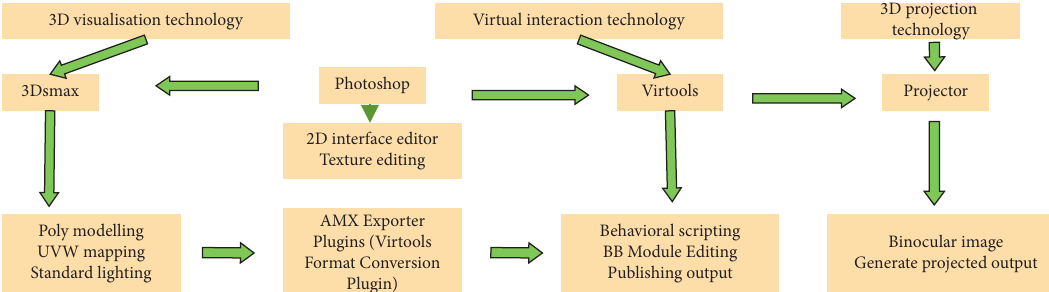
Figure 6: Virtual interactive display design to realize the 3D stereo effect of ancient buildings under multichannel stereo